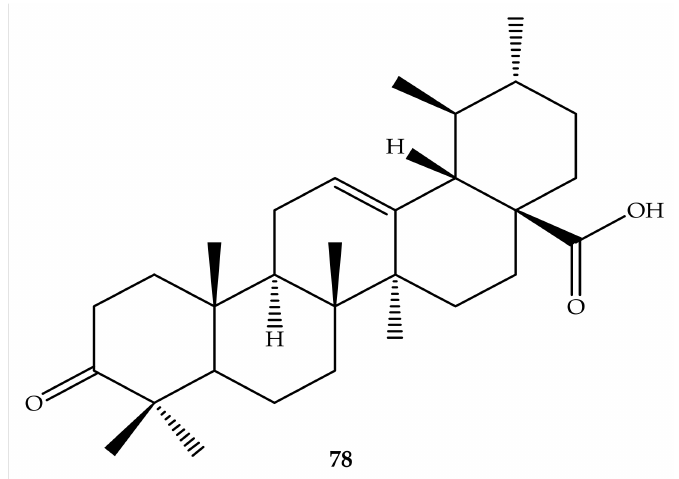
Figure 9. Some reported UA